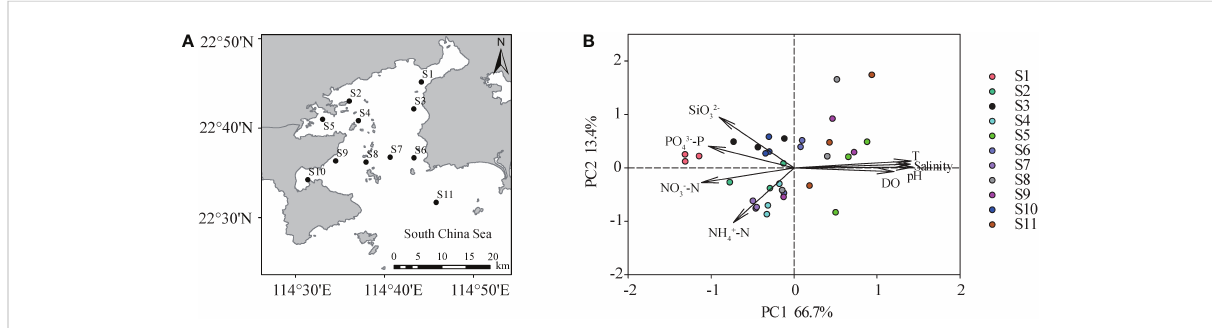
FIGURE 1 Map of sampling locations in the subtropical Daya Bay, Guangdong, China (A) and principal component analysis (PCA) depicting the relationships among all of the investigated environmental variables (B) . T, temperature; DO, dissolved oxygen; SiO 2 − 3 : silicate, PO 3 − 4 , phosphate; NO − 3 , nitrate, and NH + 4 ,